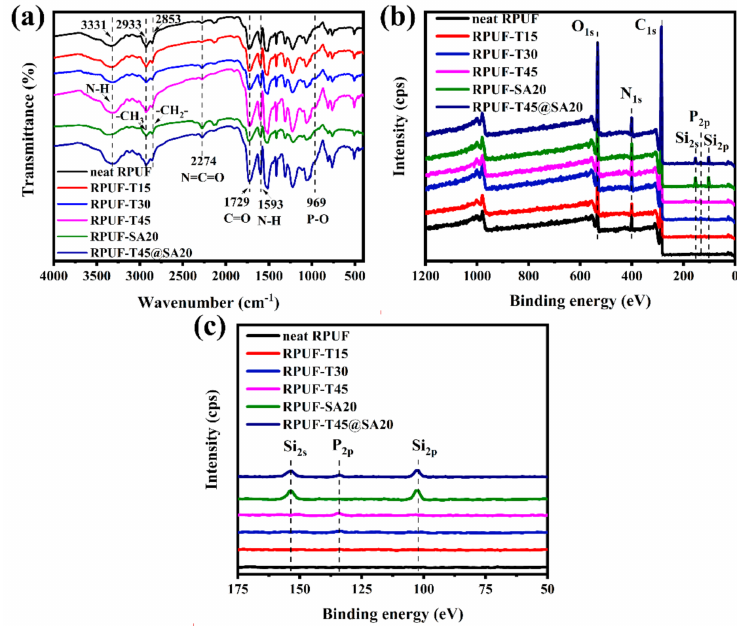
Figure 5. FT–IR spectra ( a ) and XPS curves ( b ), ( c ) of